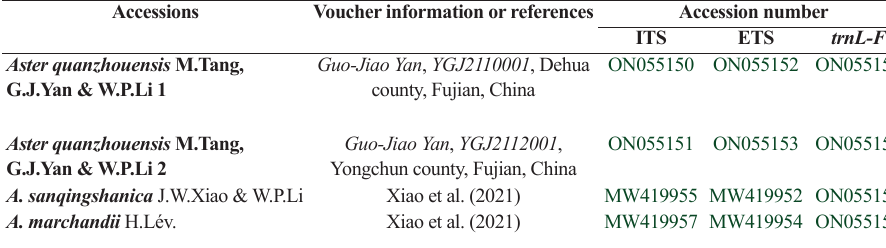
Table A1. Taxa sampled, vouchers and GenBank accessions. The newly sequenced samples are high- lighted in